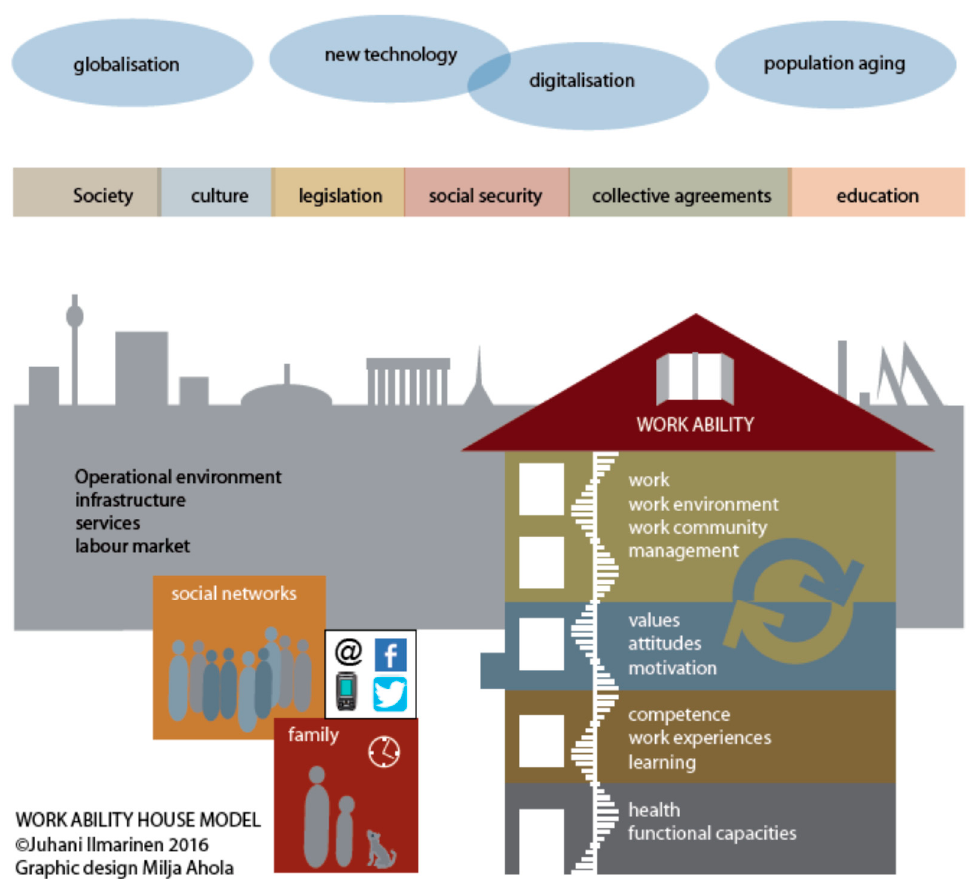
Figure 1. The work ability house model. The floors of the house, as well as family and social networks, indicate dimensions that affect work ability. Management and leadership skills on floor 4 have the strongest effect on work ability. In the third floor, the single factors like appreciation, trust, fair treatment, and support effect workplace well-being. Sustainable balance between factors of work and human resources creates good work ability.